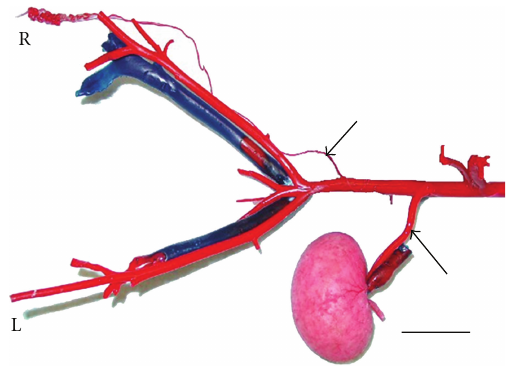
Figure 2: Vascular casting of caudal abdominal aorta from a fertile six-year-old male alpaca. This male had sired many o ff spring and had recently produced pregnancies. Under general anesthesia, the abdominal aorta and caudal vena cava were cannulated near the origin of testicular artery and insertion of the testicular vein, respectively. The alpaca was then euthanized under anesthesia by exsanguination and Batson’s no. 17 casting resin (red for arterial and blue for venous) injected through the abdominal aorta and caudal vena cava cannulas using a peristaltic pump. The pelvic region was dissected away from the cadaver and then placed into a 6% potassium hydroxide solution for 72 hours at room temperature to remove any remaining tissue. The left (L) renal artery (bottom arrow), right (R) testicular artery (top arrow), and the termination of the abdominal aorta are shown. Bar =